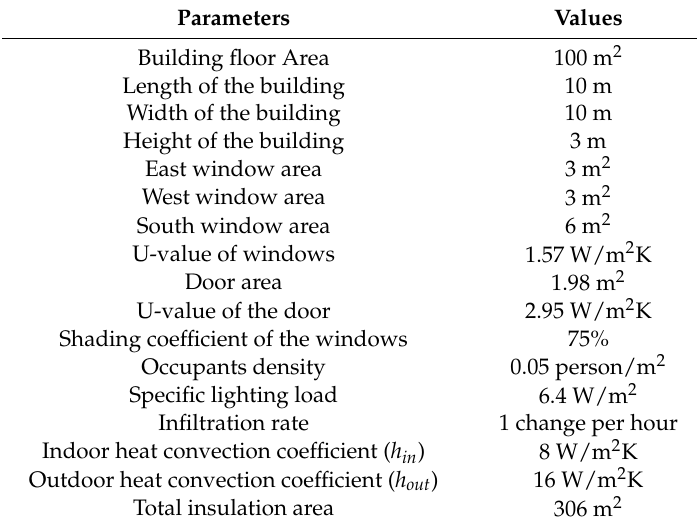
Table 2. Building parameters.